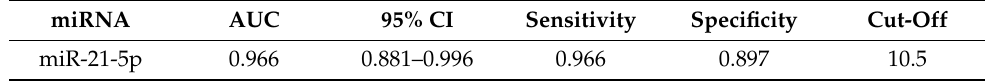
Table 2. Diagnostic value of tumor-derived EVs-miR-21-5p in esophageal